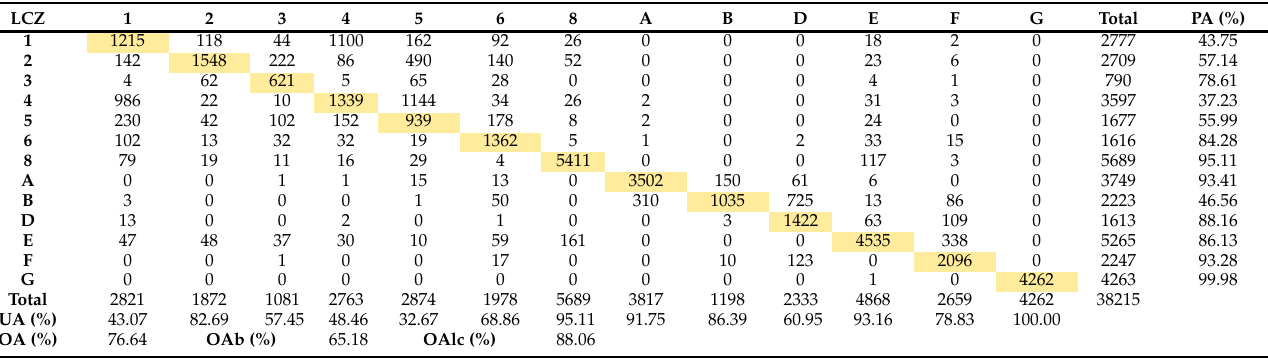
Figure 2. Local Climate Zone (LCZ) classification of Wuhan in 2018 [49]. Used with permission. Table 2. Confusion matrix of LCZ classes.